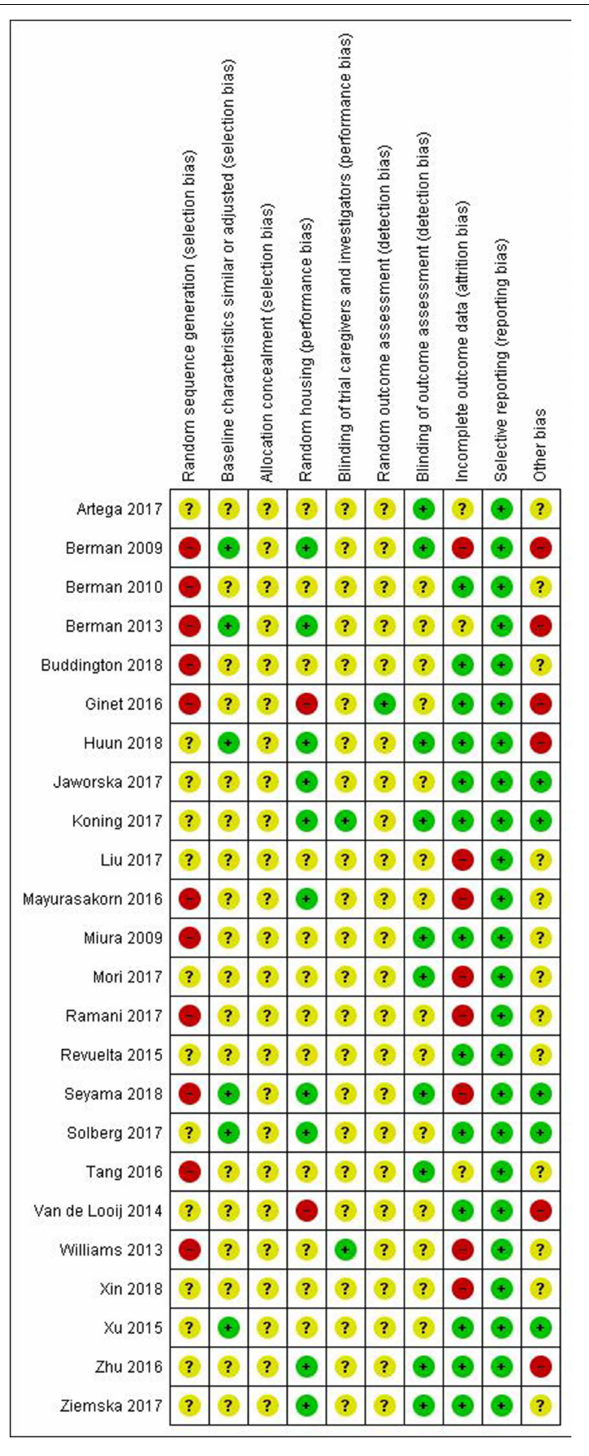
The amino acid glycine acts as an important inhibitory neurotransmitter in the brain. The effects of glycine treatment were described in one study in a rat model of neonatal